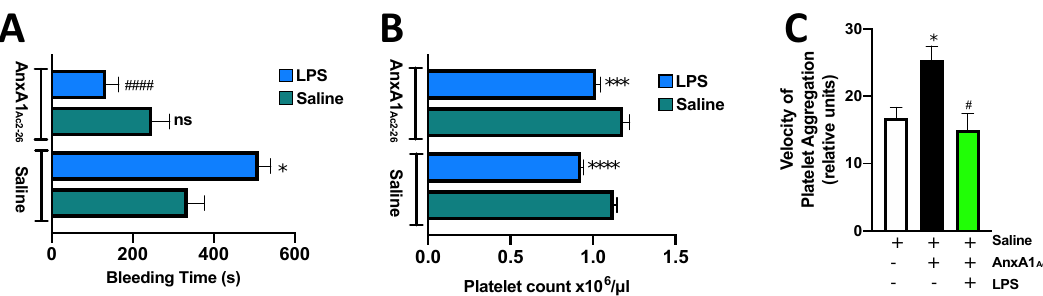
Figure 2. AnxA1 Ac2-26 treatment inhibits endotoxin-induced activation of the platelet activation. ( A ) tail bleeding times and ( B ) peripheral blood platelet counts were assessed following saline (vehicle) or AnxA1 Ac2-26 (4 mg / kg) administration for 20 min following 2 h saline (vehicle) or LPS (0.4 mg / kg) administration. ( C ) Isolated platelets were treated with saline or LPS (7.5 µ g / mL) with or without AnxA1 Ac2-26 (1 µ g / mL) and the velocity of aggregate formation was measured using a low-angle light-scattering technique. Data are means ± SEM of 5–6 mice / group. * p < 0.05, *** p < 0.001, **** p < 0.0001 vs. corresponding vehicle (saline). # p < 0.05, #### p < 0.0001 vs. corresponding LPS group. ns—non-significant vs. corresponding saline group.